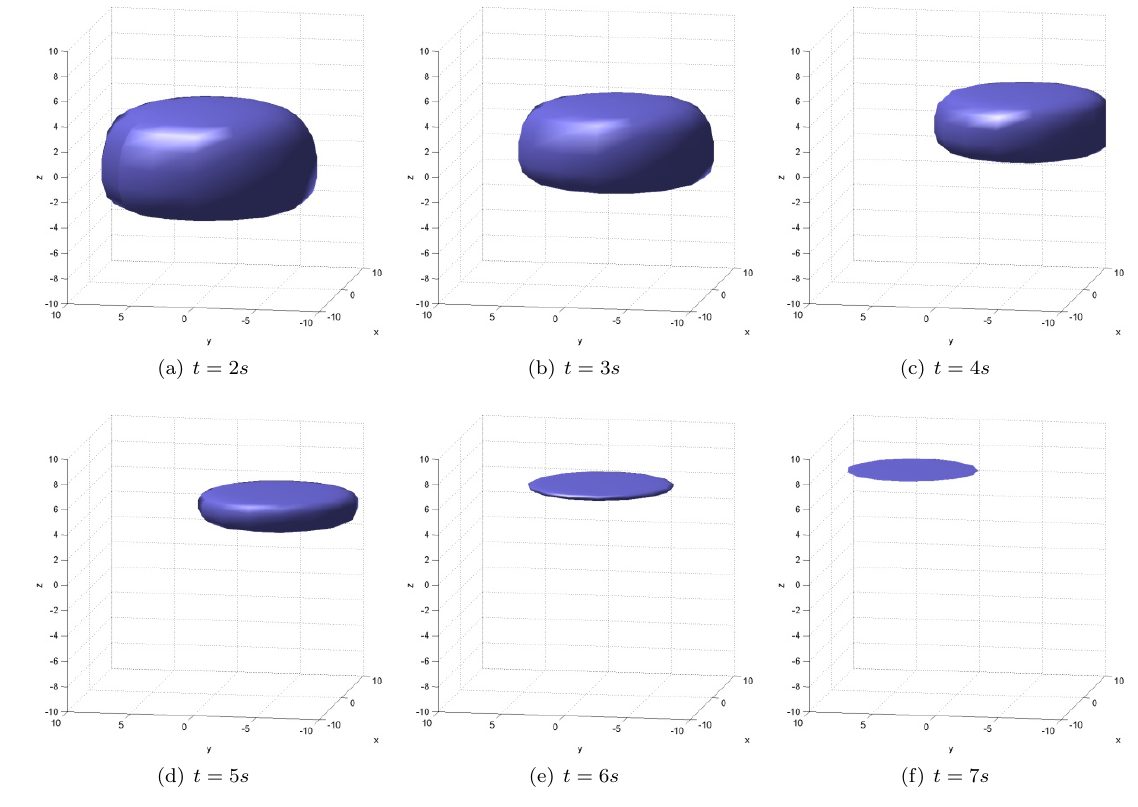
Figure 1: Contracting volume of a nonlinear